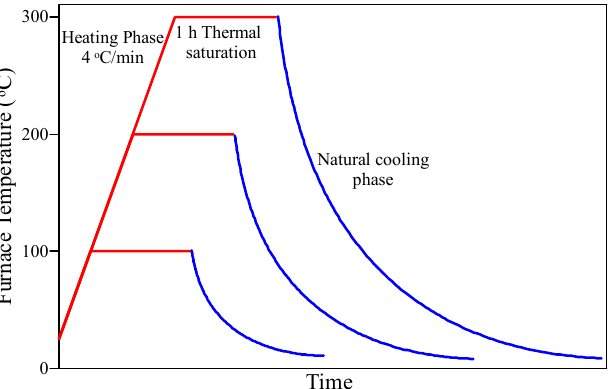
Figure 3. Furnace temperature-time relationships of the desired temperature levels.